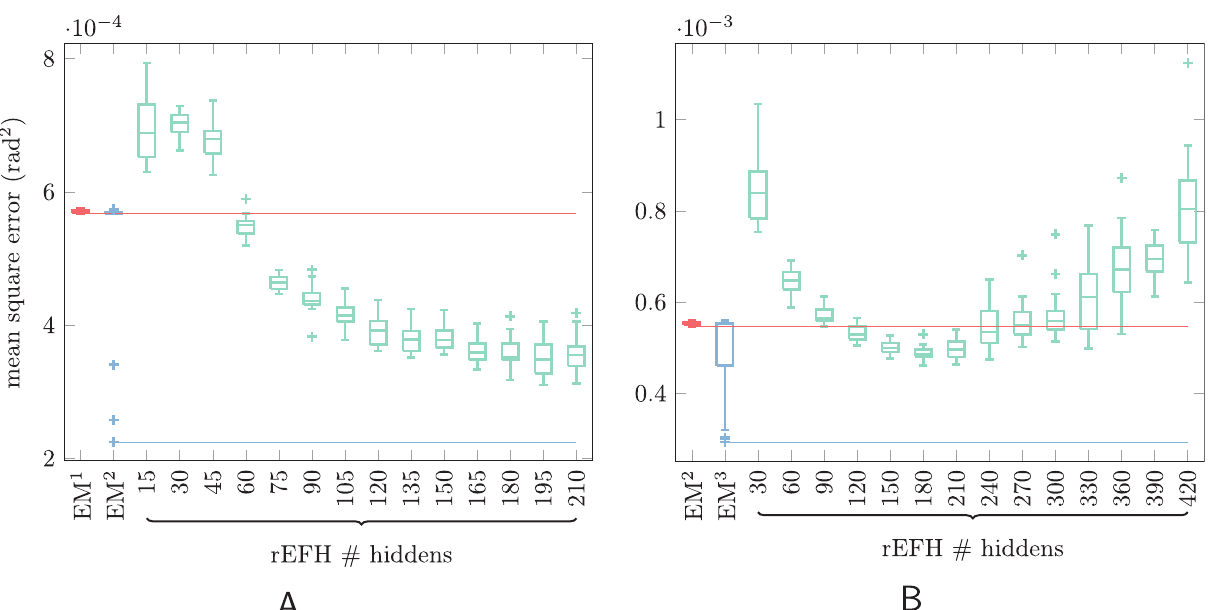
Fig 4. Box-and-whisker plot of MSEs for EM-based models and for rEFHs of various sizes. Each box corresponds to 20 networks trained de novo and tested on a common data set. Median MSE for each model is marked with a horizontal line; the box contains the interquartile range; whiskers extend to 1.5× the interquartile range, beyond which outliers are marked with plus signs. Performance among the EM-learned linear dynamical systems (the first two boxes, light red and blue) varies comparatively little, although large outliers are sometimes produced. In fact, the higher-order (best performing) models are all outliers. To facilitate comparison with the rEFHs, a line extends from the best EM-based models across the entire plot. The remaining twelve boxes (turquoise) are rEFHs with different numbers of hidden units, listed on the abscissae. All have the same number of recurrent units as hidden units, and have a fixed number of “ sensory units ” : (A) 15 proprioceptive, or (B) 15 proprioceptive and 15 efference-copy. (A) The uncontrolled dynamical system. Overall, MSEs decline with increasing number of hidden/recurrent units, but appear to asymptote by 180 hidden units (ratio = 180/15 = 12). (B) The controlled dynamical system. The optimal number of hidden units is about 180 (ratio = 180/30 = 6), after which mean and variance (across networks) of MSE increases.